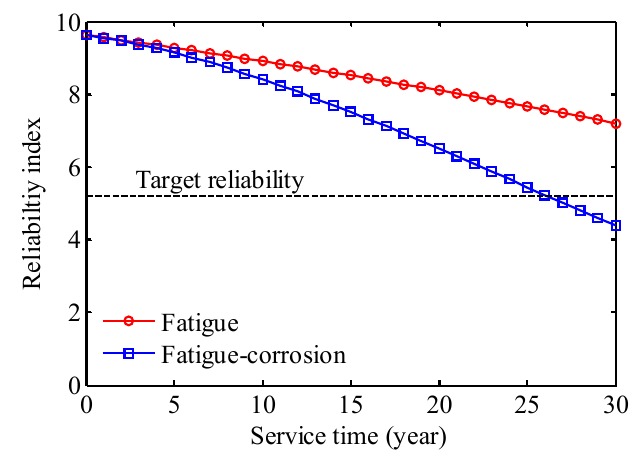
Figure 15. Series-parallel relationship of the three-level.